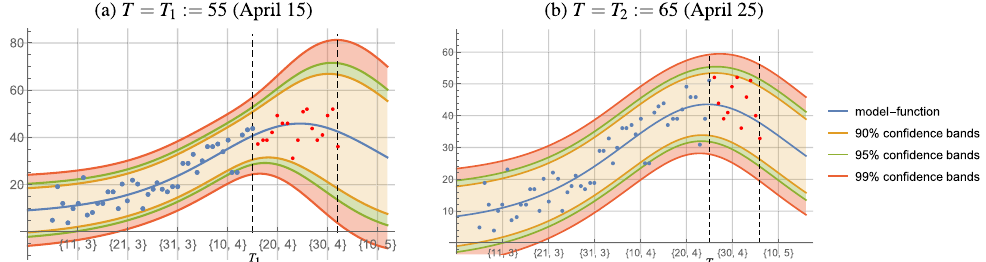
Figure 2. Graphs of the model function ϕ and confidence bands for the fit.